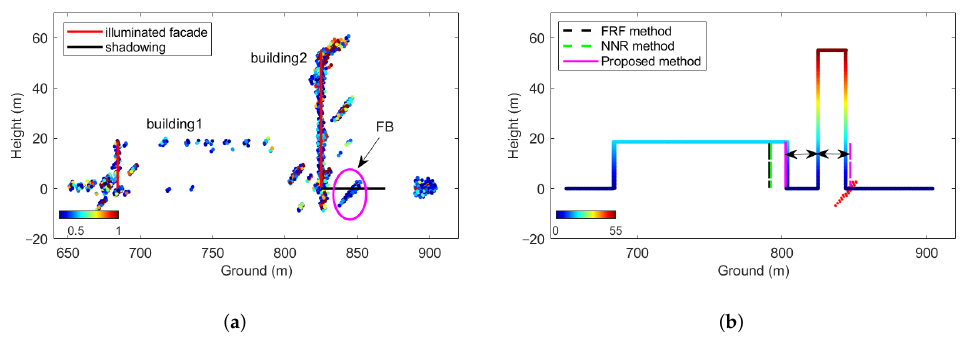
Figure 14. Results of Slice 1 in Experiment 1. ( a ) TomoSAR point cloud. The colormap indicates the normalized scattering intensity. ( b ) The reconstruction results of the back of building 1, where the line colored by height indicates the true value.